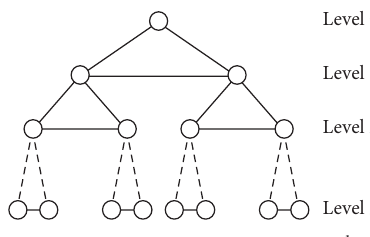
Figure 3: 1-rooted sibling tree ST 1